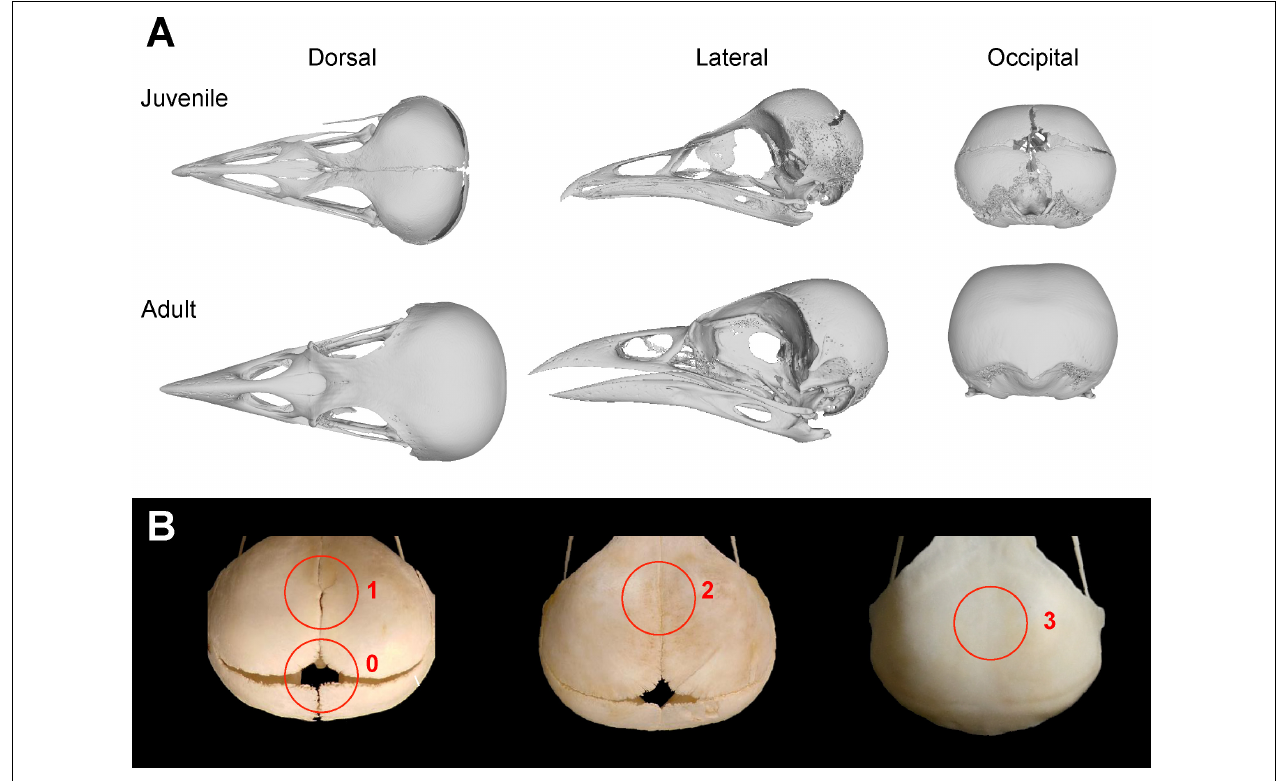
FIGURE 1 | Overview of skull bone fusion in the magpie Pica pica . (A) 3D models of a juvenile and adult skull in dorsal, lateral and occipital view. (B) Different states of sutural closure between skull bones following Bailleul et al. (2016): Neighboring bones with a minimal physical suture, but a distinct opening along the suture line (0); neighboring bones with partial physical contact, but with minor openings along the suture line (1); neighboring bones that are in physical contact having a continuous suture (2); neighboring bones are completely fused to each other (3). All specimens not in